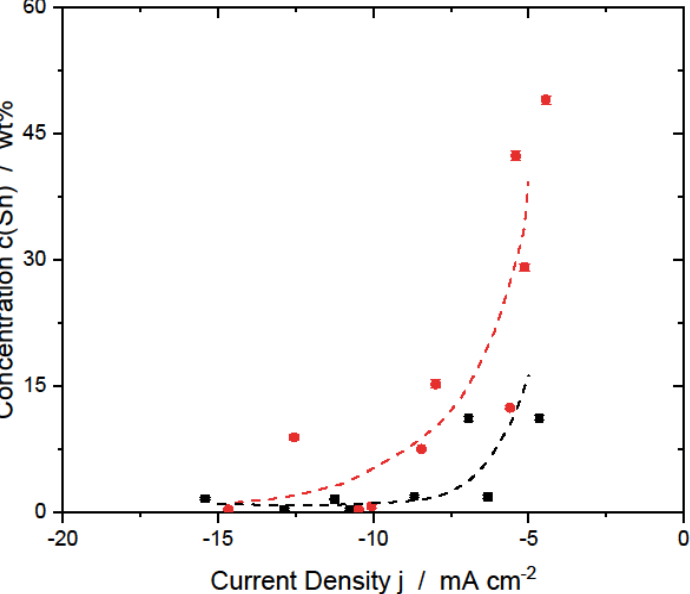
Figure 6. Sn content of the AlSn deposits (EDS) vs. current density for [EMIm]Al 2 Cl 7 –10Sn ( ■ ) and [EMIm]Al 2 Cl 7 –50Sn (●). The dashed lines are just for eye-guidance and have no physical meaning.